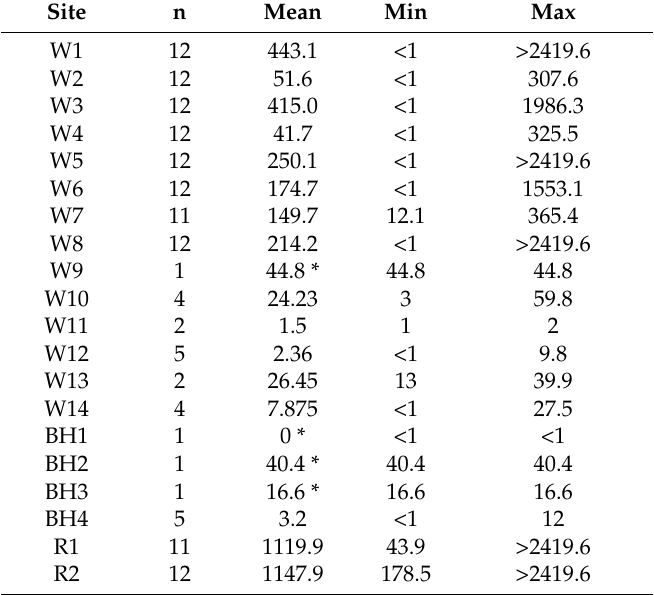
Table 2. Mean E. coli count (Most Probable Number per 100 mL; MPN/100 mL) per sampling